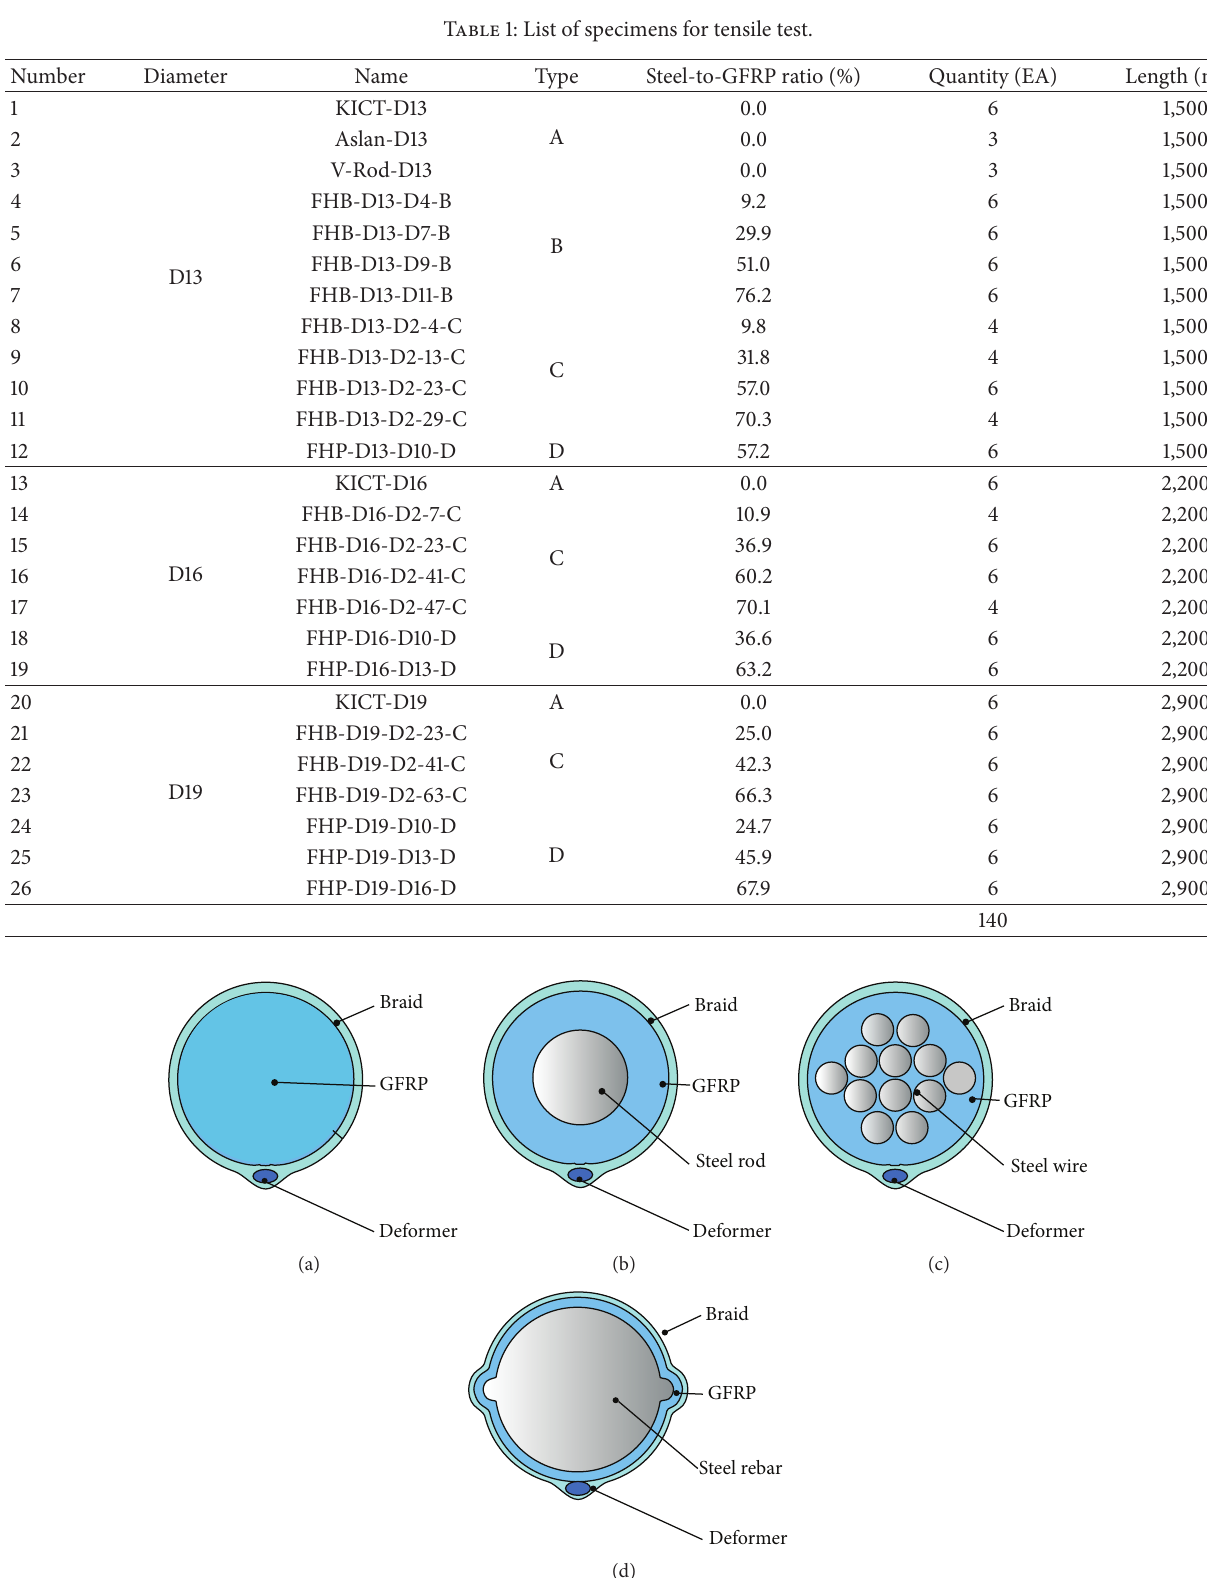
Figure 3: Cross section types of “FRP Hybrid Bar” [24]: (a) Type A (the KICT GFRP bar [8]); (b) Type B (GFRP with a steel rod); (c) Type C (GFRP with steel wires); and (d) Type D (GFRP with a steel